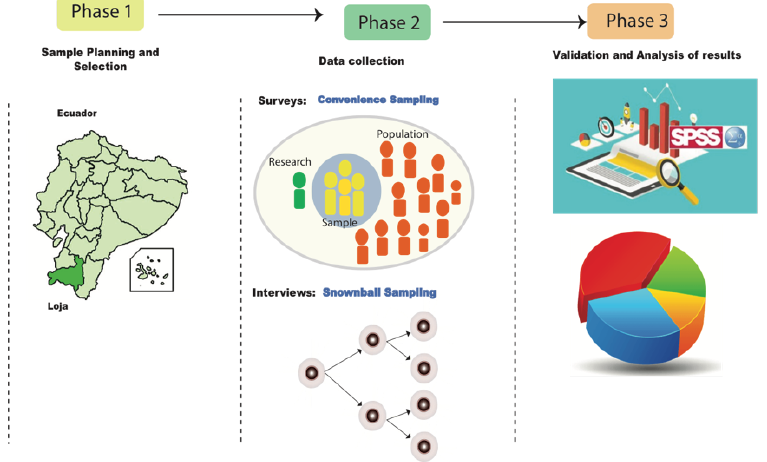
Figure 2. Implementation phases project. Phase 1: Sample Planning and Selection involves prepara- tory activities to define sampling techniques and delimit the area of study. Phase 2: Data Collection is used for the application of surveys and interviews. Phase 3: Validation and Analysis of results using the SPSS